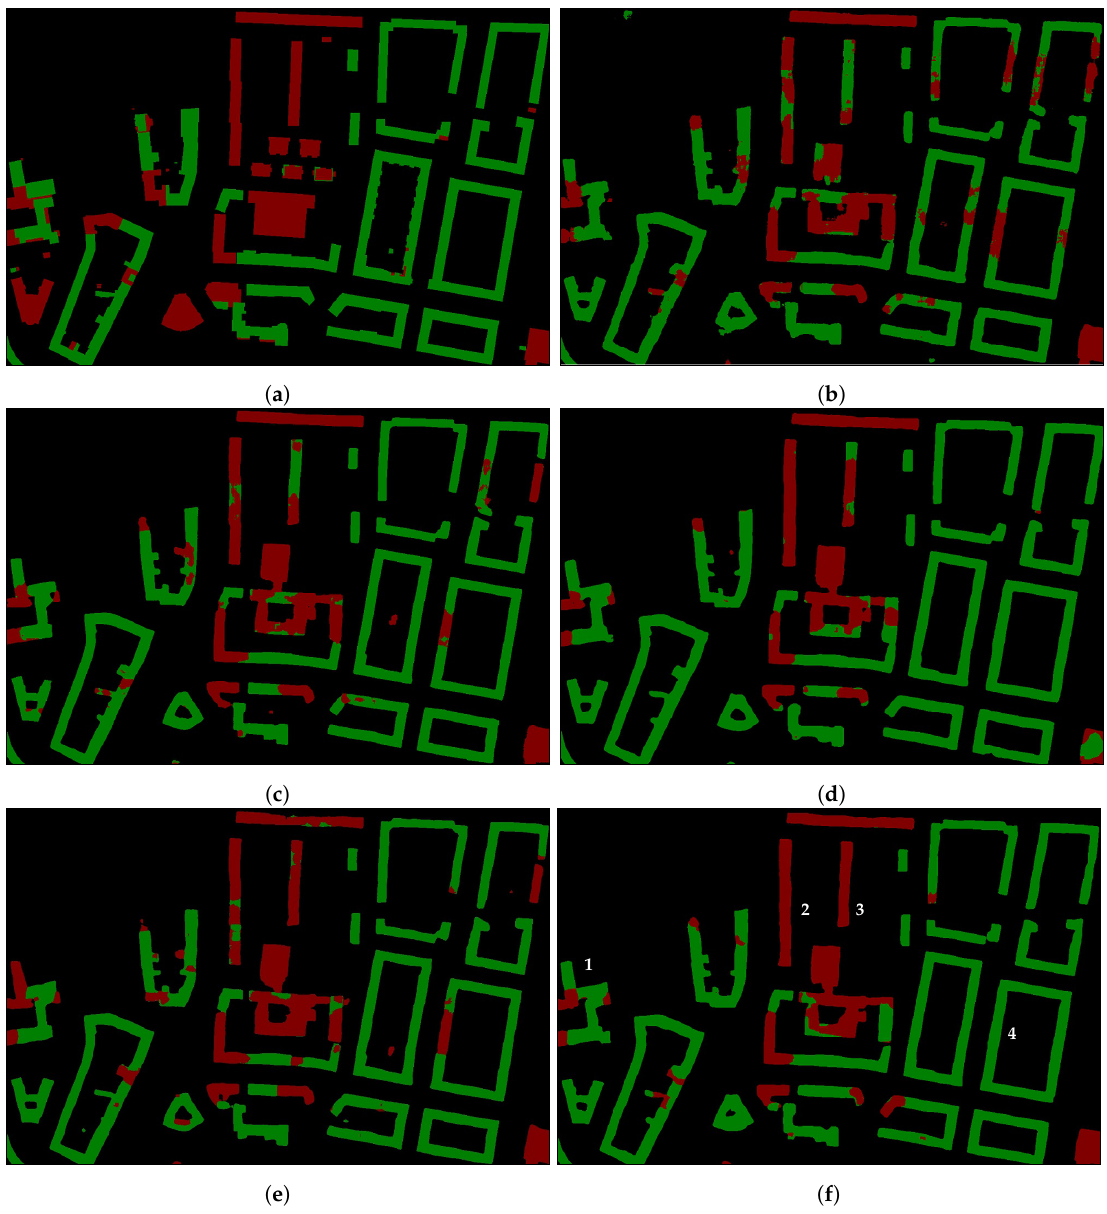
Figure 8. Visual comparison of roof classification maps over selected urban areas, generated by cGAN with least squares residuals using ( b ) the one-stream generator based on the UNet network for multiple tasks, ( c ) the one-stream generator based on the ResNet34 network for multiple tasks, ( d ) the one-stream generator based on the DeepLabv3+ network for multiple tasks, ( e ) the two-stream generator network jointly trained UNet and ResNet34 architectures for multiple tasks, ( f ) the two-stream generator network jointly trained UNet and DeepLab architectures for multiple tasks. ( a ) illustrates the ground truth label